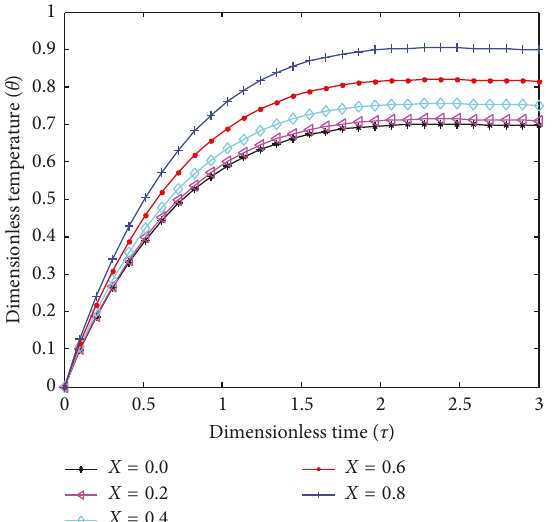
Figure 4: Temperature history in the fin at various locations when the thermal conductivity varies according to exponential-law